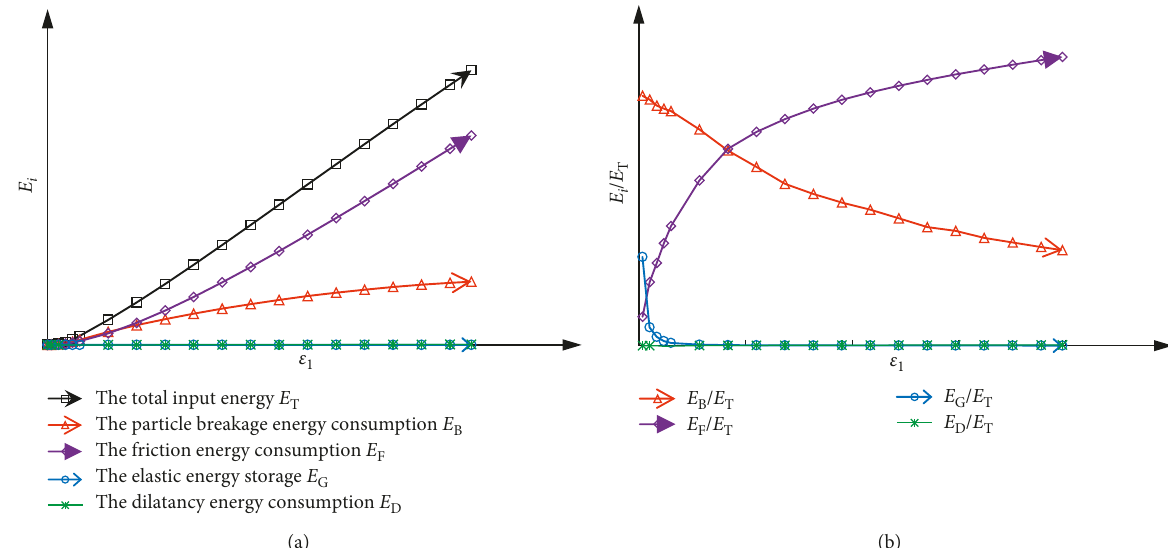
Figure 5: Schematic diagram of changes in (a) energy consumption and (b) the ratio of the energy consumption to total input energy during the loading